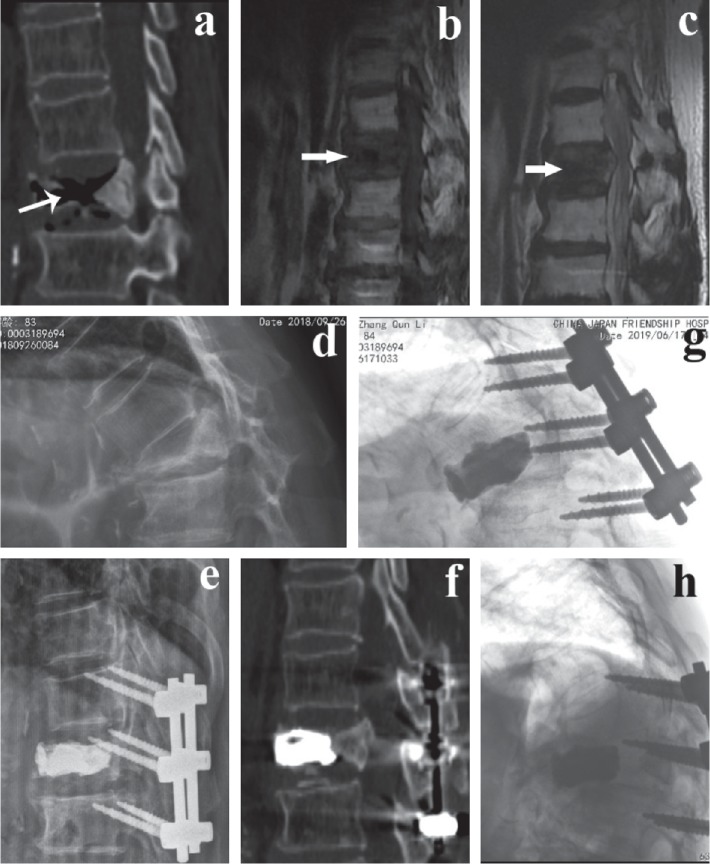
An 83-year-old male patient underwent PFVP due to L1 OVCFs with IVC complicated by neurological deficits. (a–d) Preoperative sagittal plain radiographs, T1- and T2-weighted MRI, and CT revealed an IVC and spinal cord compression at the L1 level. (e, f) Immediate postoperative plain radiographs and CT showed bone cement in the vertebral body with increased anterior vertebral height and resolved kyphosis. (g, h) Plain radiographs showed that displacement of the bone cement developed 1.5 years after surgery.